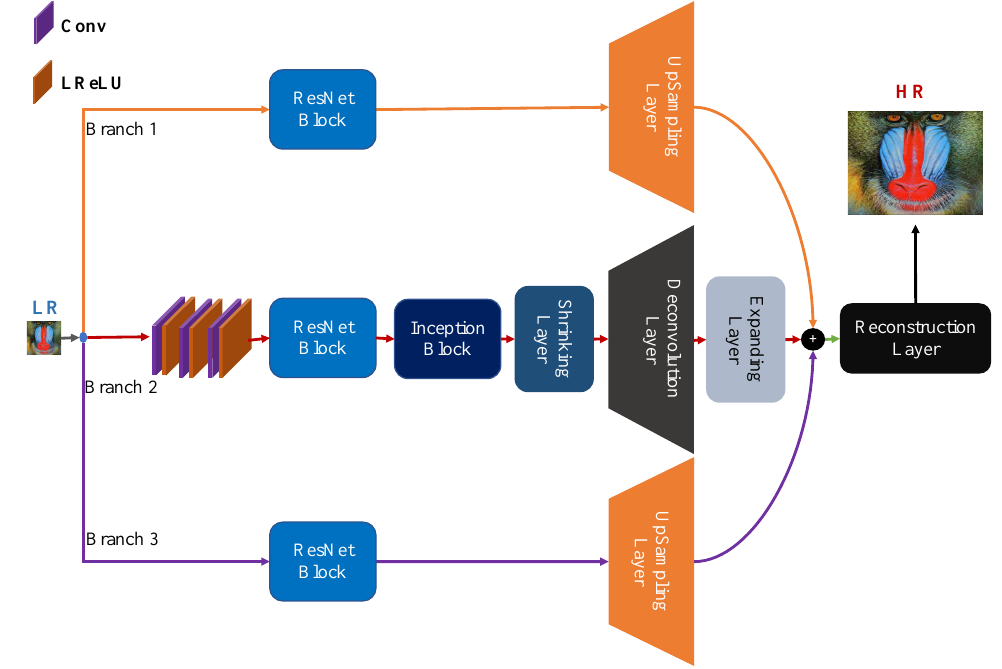
Figure 1. The proposed network architecture of our method with three parallel paths or